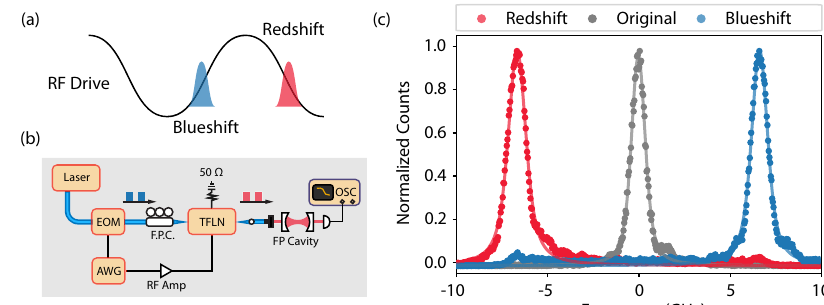
Fig. 4 | Visible spectralshearing. a Principleof spectralshearing, wherethe rising (falling)edgeofasinusoidaltoneisusedtoprovidealinearphaseacrossanoptical pulseinordertoblue(red)shiftitsfrequency. b Diagramoftheexperimentalsetup. An arbitrary waveform generator (AWG) is used to generate both 1ns square electrical pulses and the 100MHz sinusoidal drive for the phase modulator. The square electricalpulses generate square opticalpulsesviaa commercialamplitude EOmodulator, whichare then routedto the low V π TFLNphase modulator. The RF